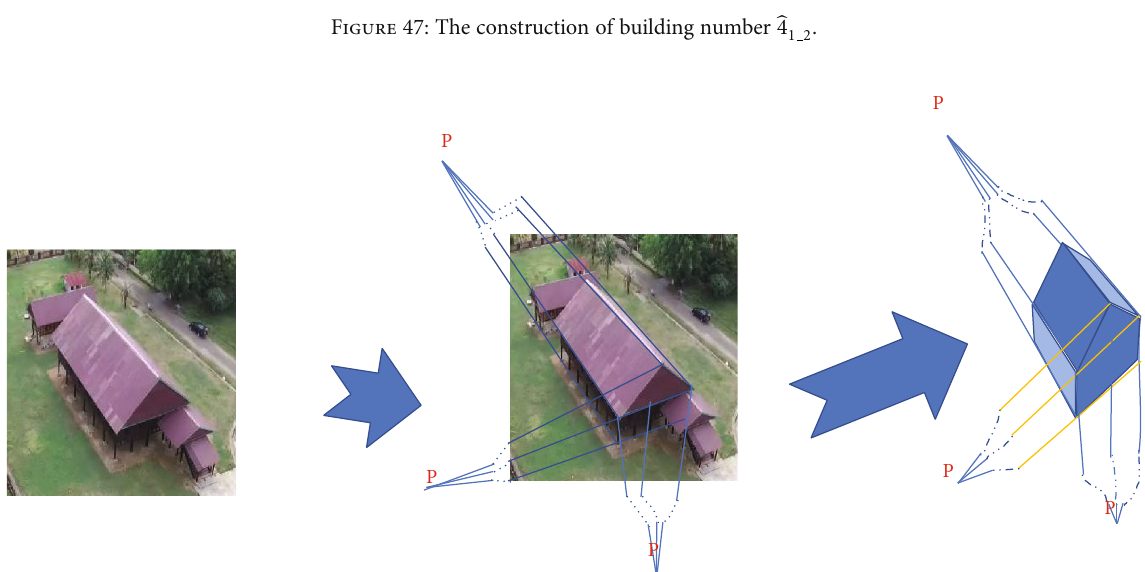
Figure 48: The construction of building number ̂ 4